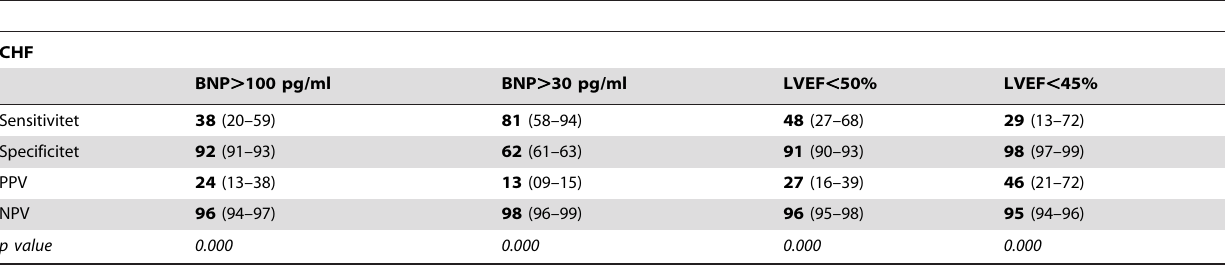
Table 2. Prognostic performances of BNP and LVEF in predicting hospitalization for congestive heart failure during follow